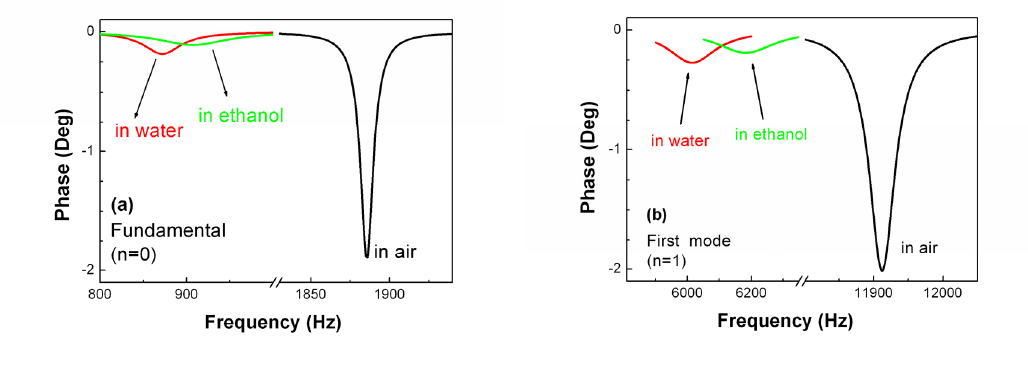
Figure 4. Phase versus frequency for an MSMC in air, water, and ethanol, respectively. (a) The fundamental bending mode (n=0) resonance spectra. (b) The first bending mode (n=1) resonance